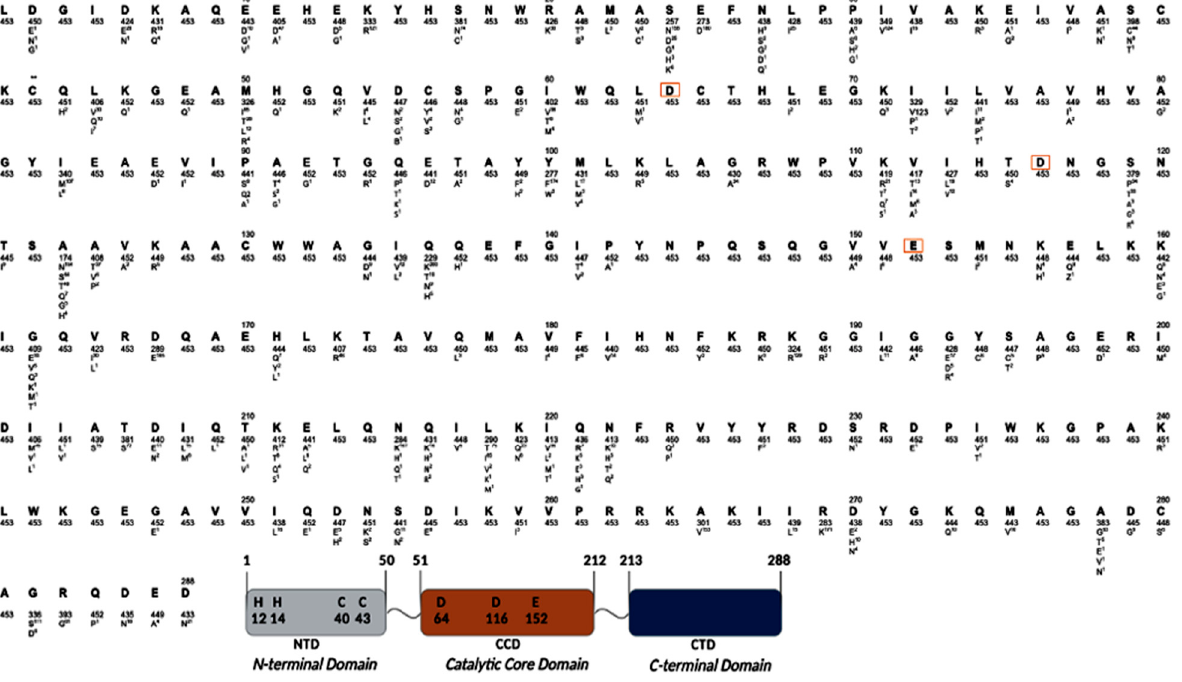
Figure 4. Distribution of variants among HIV-1 subtype C integrase sequences. The number at the top is the amino acid position in the integrase gene (1-288), and the consensus subtype B sequence is indicated below the number. Beneath the consensus, the number indicates the number of sequences containing the amino acid at the indicated position. The variant amino acid at each position is indicated along with number of sequences with that amino acid (superscript). The HHCC zinc- binding motifs are indicated by **, the amino acid of the DDE active sites are indicated by red boxes. The N-terminal domain is indicated in gray at positions 1-50, while the catalytic core domain (CCD) at positions 51-212 is indicated in orange, and the C-terminal domain (CTD) at positions 213-288 is indicated in blue.